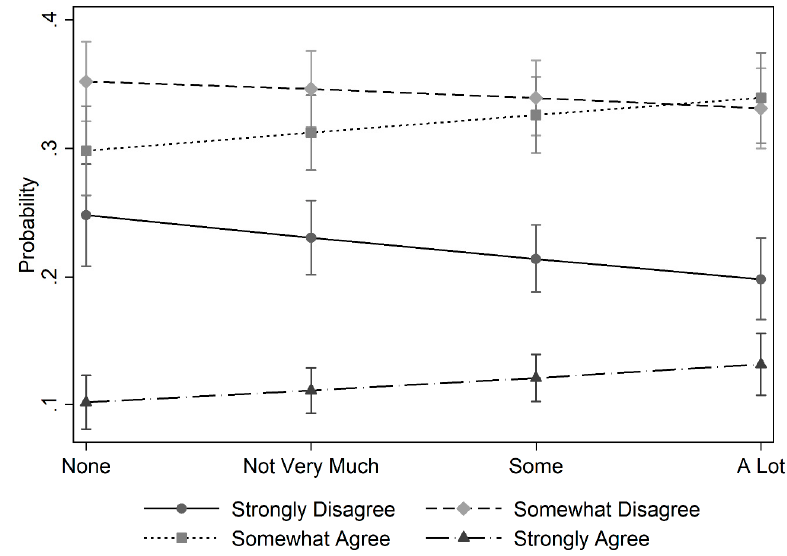
Figure 6. Probabilities for position on immigrants take by linked fate.